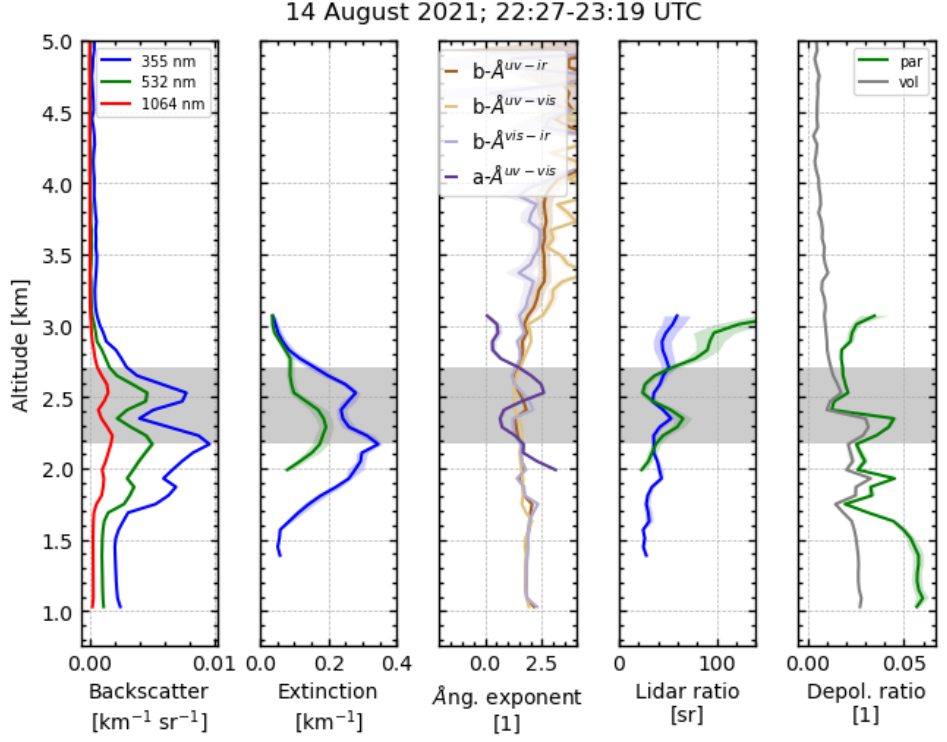
Figure 5. Vertical profiles of optical parameters measured in Potenza on 14 August 2021 from 22:27 to 23:19 UTC with the multi-wavelength Raman lidar MUSA. The grey rectangle shows the altitude from 2170 to 2710 m asl used for obtaining the microphysical particle properties through the inversion method.